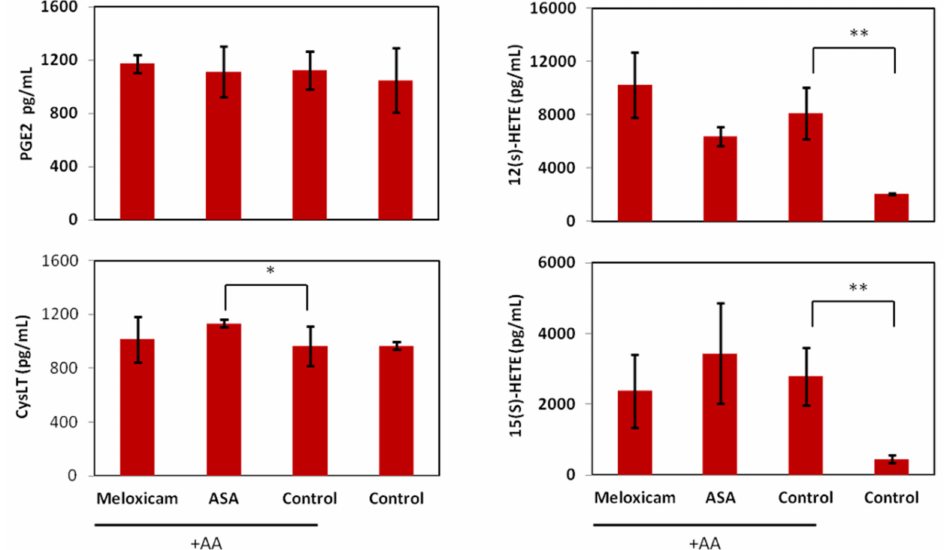
Figure 5. Effects of meloxicam and aspirin (ASA) on eicosanoid biosynthesis. Biosynthesis of PGE2, CysLT, 12(S)- and 15(S)-HETE acid (pg/mL) after 3 h incubation with IC 50 of the inhibitors plus 10 µ M AA. Values are the mean of three independent assays. Error bars represent SD. Statistical significance by two-tailed unpaired t -test (** p < 0.01 * p <